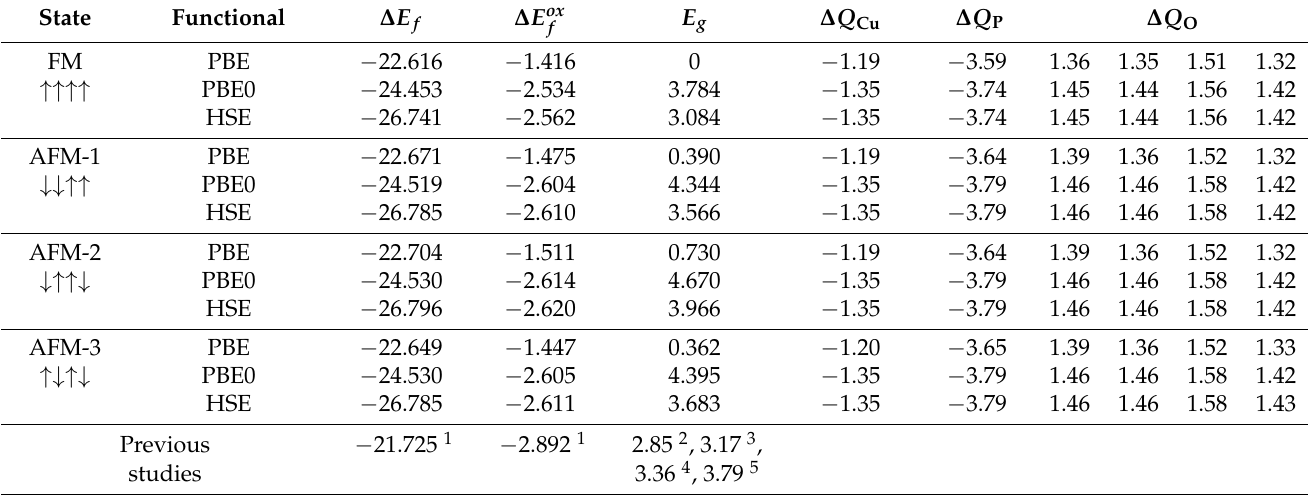
Table 3. Calculated formation energy ∆ E f (eV/f.u.), formation energy from oxides E ox band gap E g (eV), and effective atomic charges ∆ Q Cu , ∆ Q P , and ∆ Q O , in α -Cu 2 P 2 O 7 . Elementary charge units ( e ) are used; negative charge values denote a lack of electrons. Previous experimental and theoretical values are quoted for